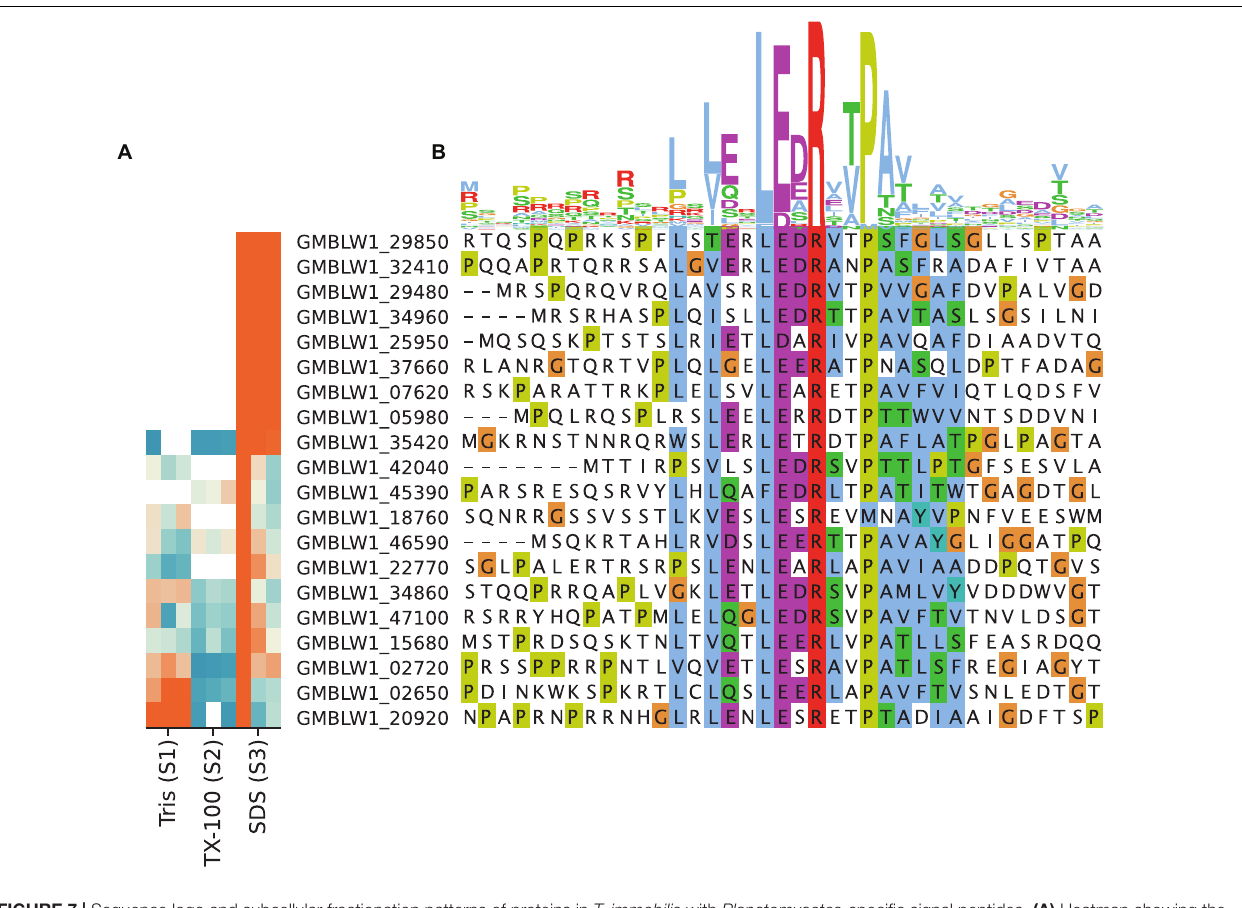
FIGURE 7 | Sequence logo and subcellular fractionation patterns of proteins in T. immobilis with Planctomycetes- specific signal peptides. (A) Heatmap showing the relative abundance of 20 expressed proteins (colored according to Figure 4 ), each carrying the Planctomycetes specific signal peptide as a function of the respective subcellular fraction [Tris soluble (S1), Tris/TX-100 soluble (S2), and Tris/SDS soluble (S3)]. (B) Sequence alignment of experimentally identified proteins in T. immobilis carrying a Planctomycetes -specific signal peptide. The sequence logo is shown on top of the aligned